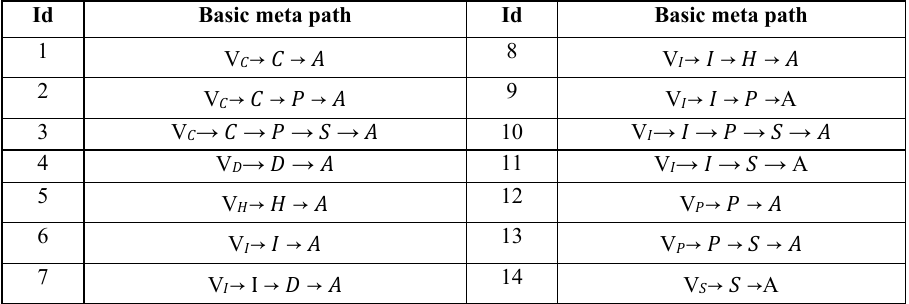
Table 2. The basic meta path in the network attack effect index system